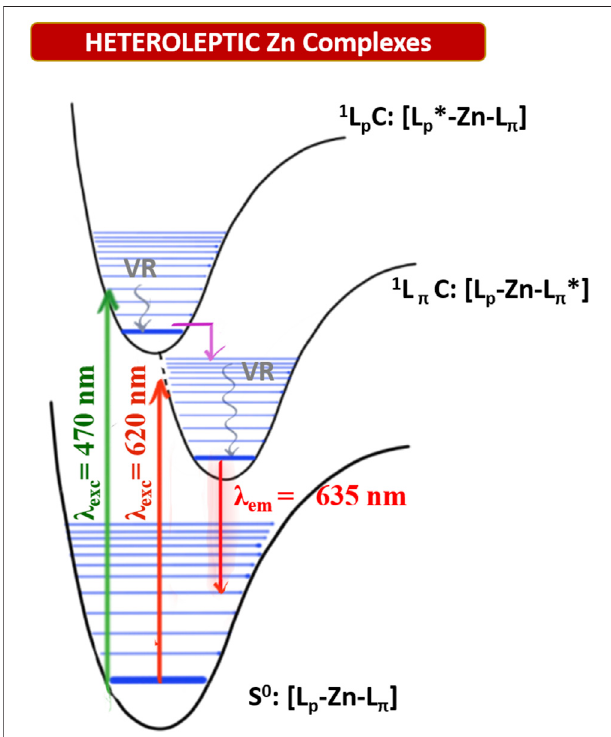
FIGURE4| QualitativeJablonski-diagramfortheinvolvedphotophysical processes in heteroleptic Zn II complexes. (VR: Vibrational radiation; 1 L p C: singlet excited state centered on the plain dipyrrin; 1 L p C: singlet excited state centered on the π -extended dipyrrin. Pink arrow: rapid interligand nonradiative